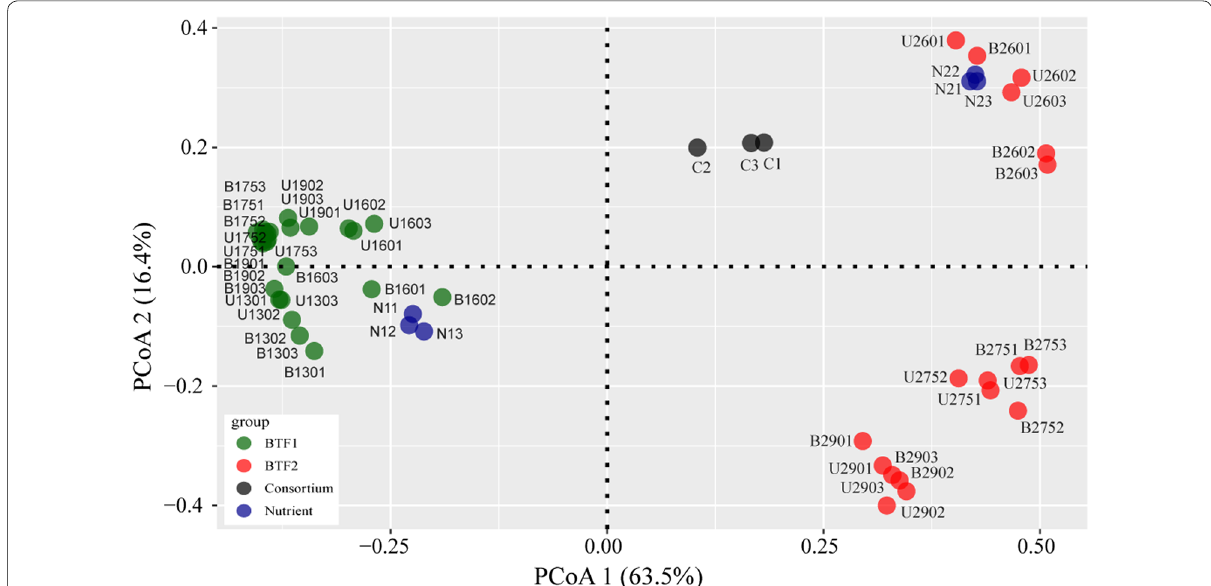
Fig. 3 Principal coordinate analysis (PCoA) of microbial communities. Samples collected from the bottom layer and upper layer are labeled by letter respectively. First number denote BTF1 or BTF2. Last two numbers indicates the sampling day. Sample from initial inoculums are showed with black circles, and sample from recycling nutrient showed with blue